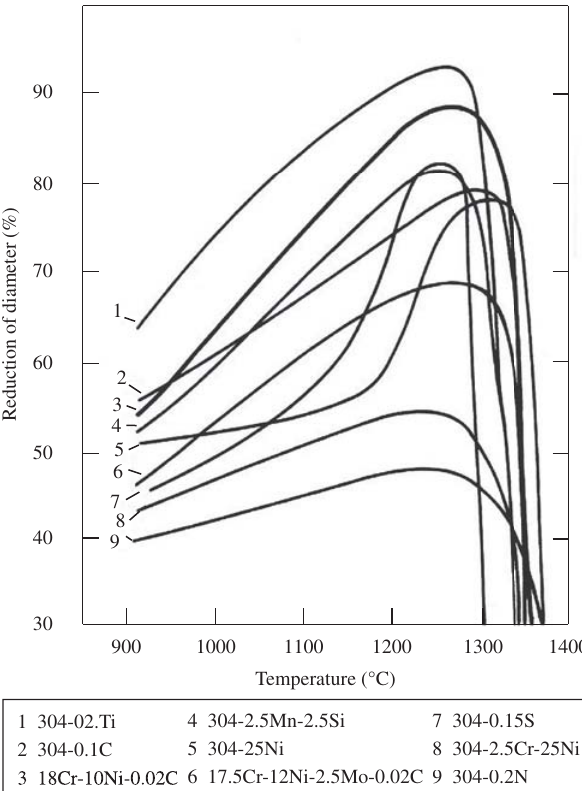
Operational limit temperature (°C) for an increase of 10 mg.cm –2 in 1000